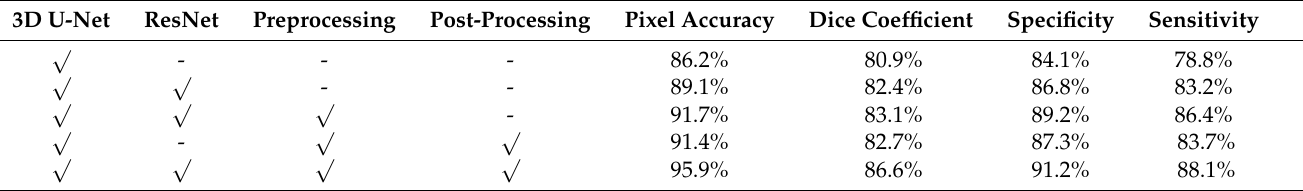
Table 3. Ablation study of the effectiveness of the proposed method by comparing the performance on the KiTs19 dataset: Dice coefficients and